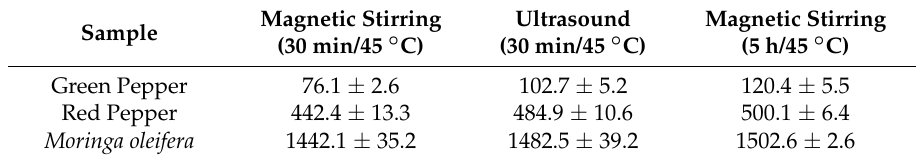
Results are means of triplicate determinations ± standard